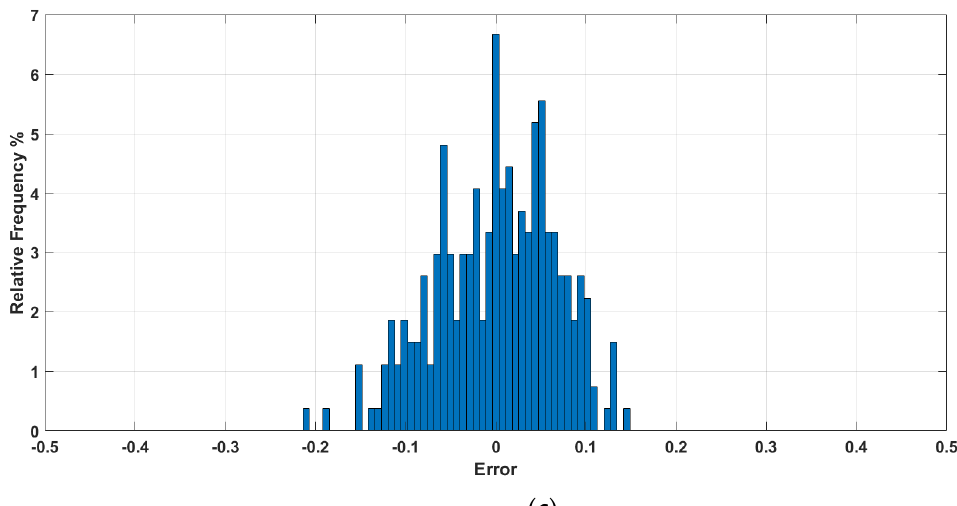
Figure 5. Distribution of the error in estimating the parabolic coefficients of the refraction index expression Ri analyte = a λ 2 + b λ + c : ( a ) coefficient a , ( b ) coefficient b and ( c ) coefficient c .